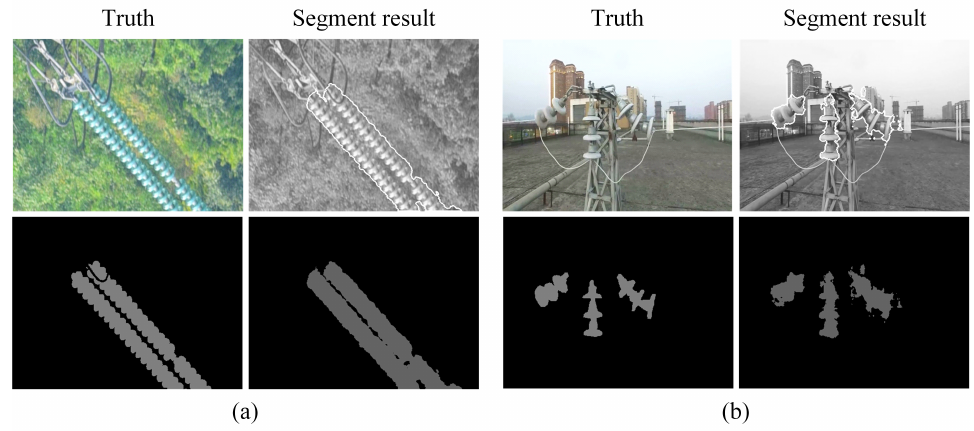
Figure 9. The examples of segmentation results. ( a ) The segmentation result on actual inspection. ( b ) The segmentation result on simulated scene.